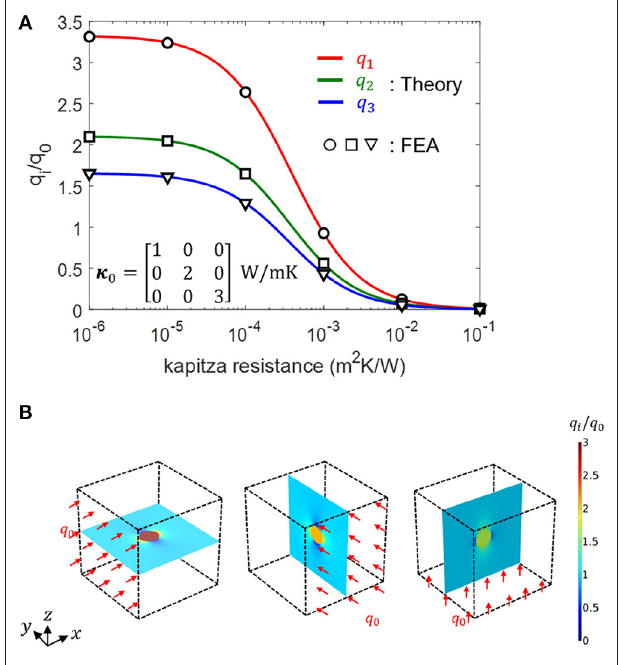
FIGURE 8 | (A) Normalized heat flux within an inhomogeneity with respect to the interfacial thermal resistance in a single inhomogeneity problem. The inhomogeneity is an isotropic material for which κ 1